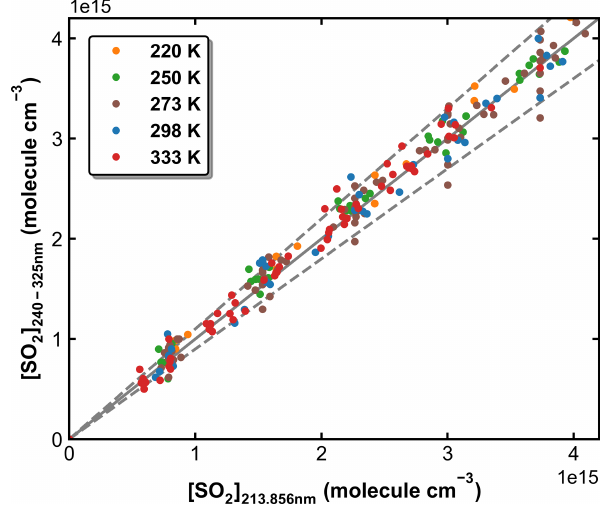
Figure 3. SO 2 concentrations measured in experiments at different temperatures using the multi-pass absorption cell upstream of the reactor ( y axis) and the 213.86nm absorption cell downstream of the reactor ( x axis). The solid line represents y = x , and the dashed lines are y = 1 . 1 x and y = 0 . 9 x